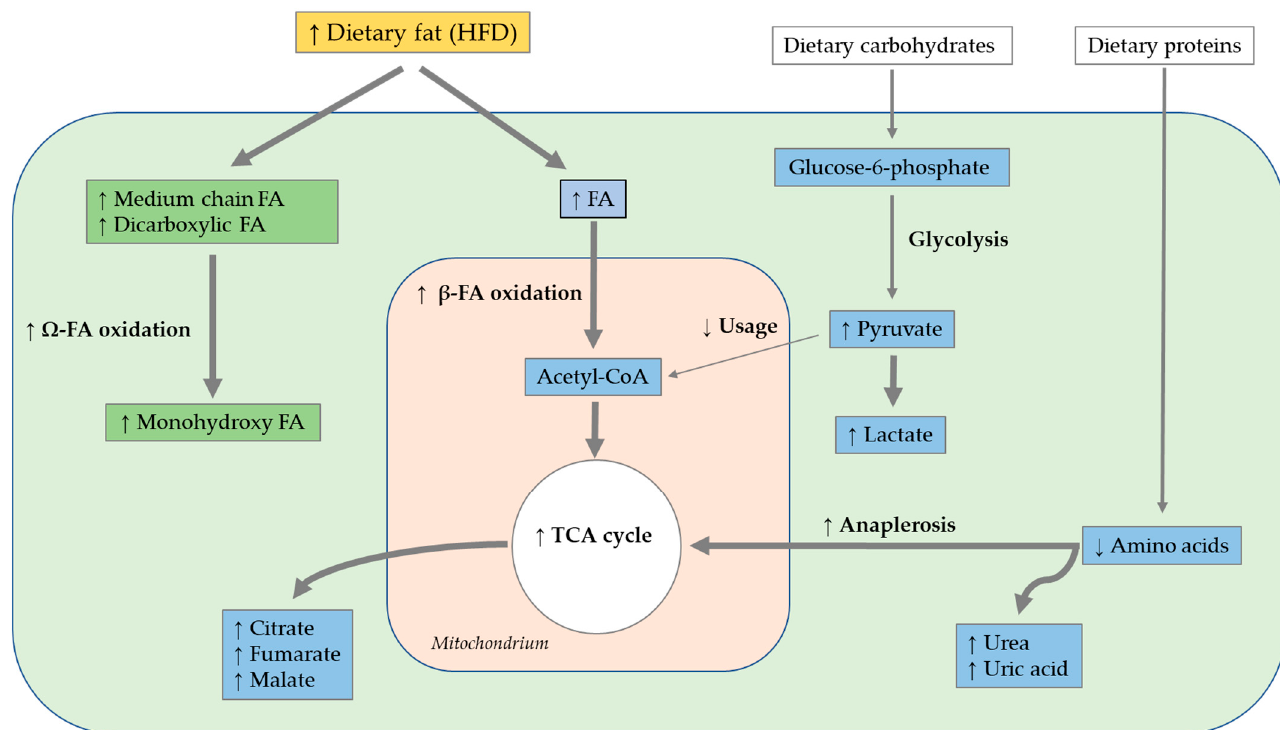
Figure 15. Metabolomic changes in Drosophila melanogaster fed a high-fat diet (HFD). Metabolites that are affected in adult flies are in blue boxes, and those that are specifically altered in larvae are in green boxes. In adult flies, an HFD led to enhanced levels of acetyl-coenzyme A (acetyl-CoA), indicating an increased β - oxidation of fatty acids (FAs). In line with this, citrate, malate and fumarate concentrations are increased, which points to the stimulation of the tricarboxylic acid (TCA) cycle, fueled by the acetyl-CoA surplus. An overload of the TCA cycle by β -oxidation-derived acetyl-CoA is further supported by elevated levels of pyruvate and lactate, indicating a decreased utilization of glycolysis products by the TCA cycle [156,172]. In addition, amino acid levels declined, and products of amino acid catabolism, such as urea and uric acid, were elevated. This points to an increased demand for amino acids to provide anaplerotic metabolites for the TCA cycle [172]. In larval D. melanogaster (green boxes), an increase in Ω - FA oxidation is also evident [171] (modified from [156,171,172]). ↑ increase; ↓ decrease; arrow thickness indicates flux rate.